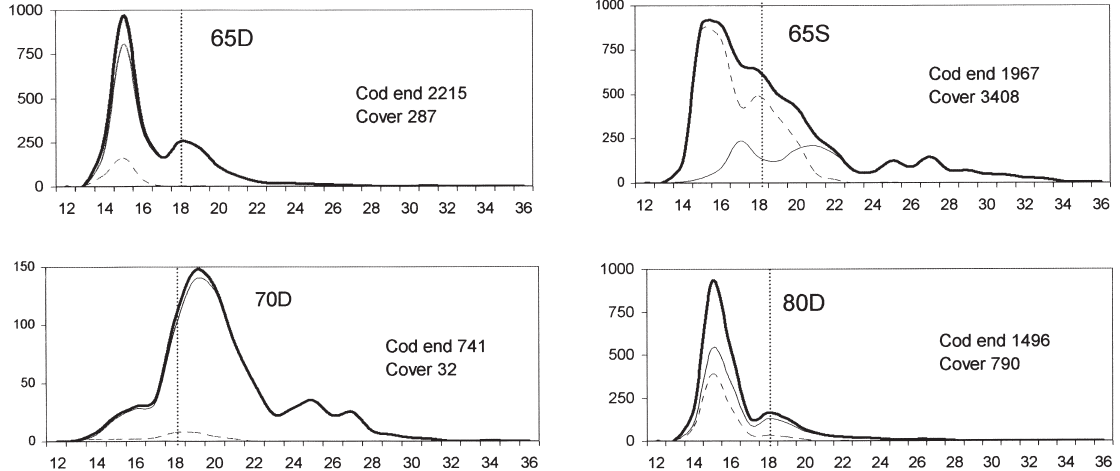
line to total numbers. Dotted vertical line indicates the minimum landing size